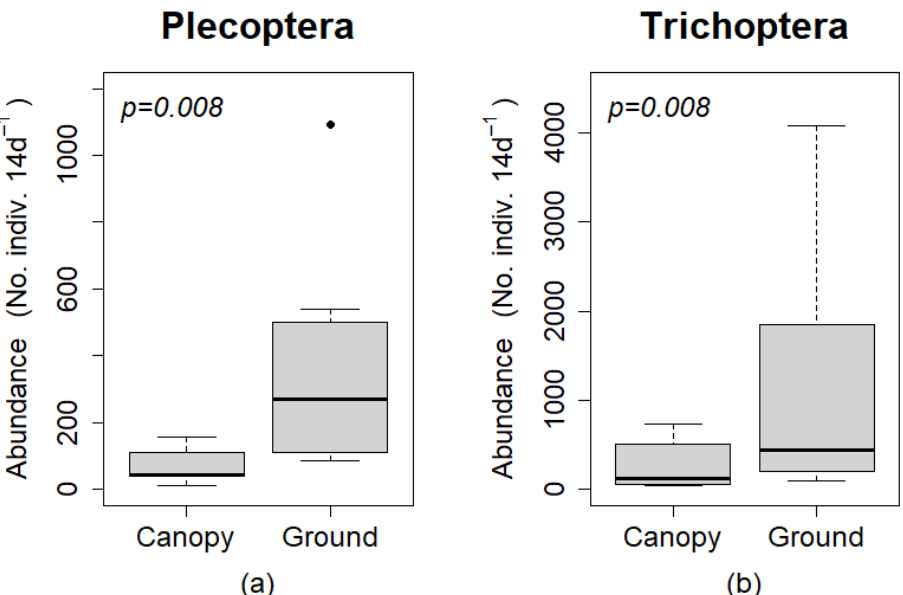
Figure 3. Box plots comparing estimated abundances (No. individuals per 14 day period) of ( a ) Plecoptera and ( b ) Trichoptera among canopy and ground traps. Boxes represent upper and lower quartiles, and whiskers extend to values no greater than or less than 1.5 times the inter-quartile range of the upper and lower quartiles, respectively. Points ( • ) are outliers outside the values of the whiskers. Statistical comparisons were performed using a Wilcoxon sign rank test.